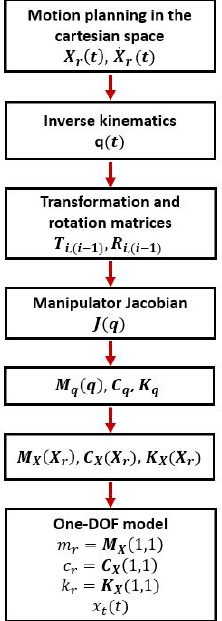
Figure 10. Flow chart of the steps taken to evaluate the terms M X ,11 , D X ,11 and K X ,11 along the trajectory of the tool. DOF: degree of freedom.